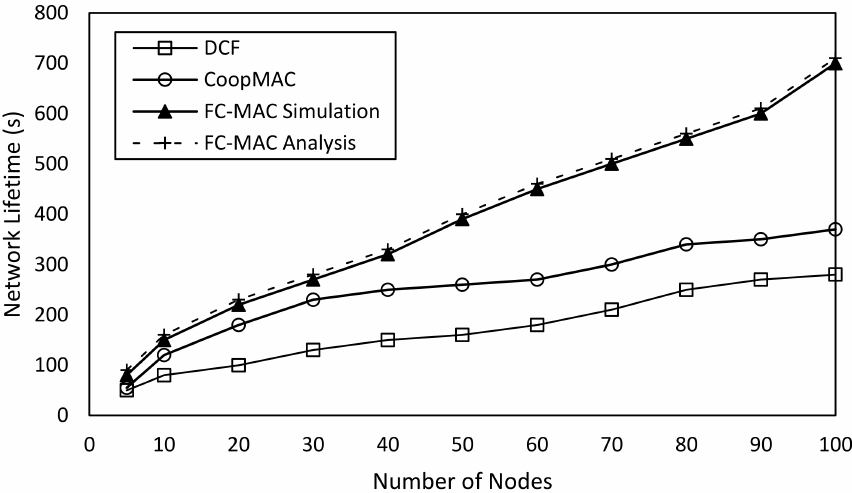
Figure 4. Network